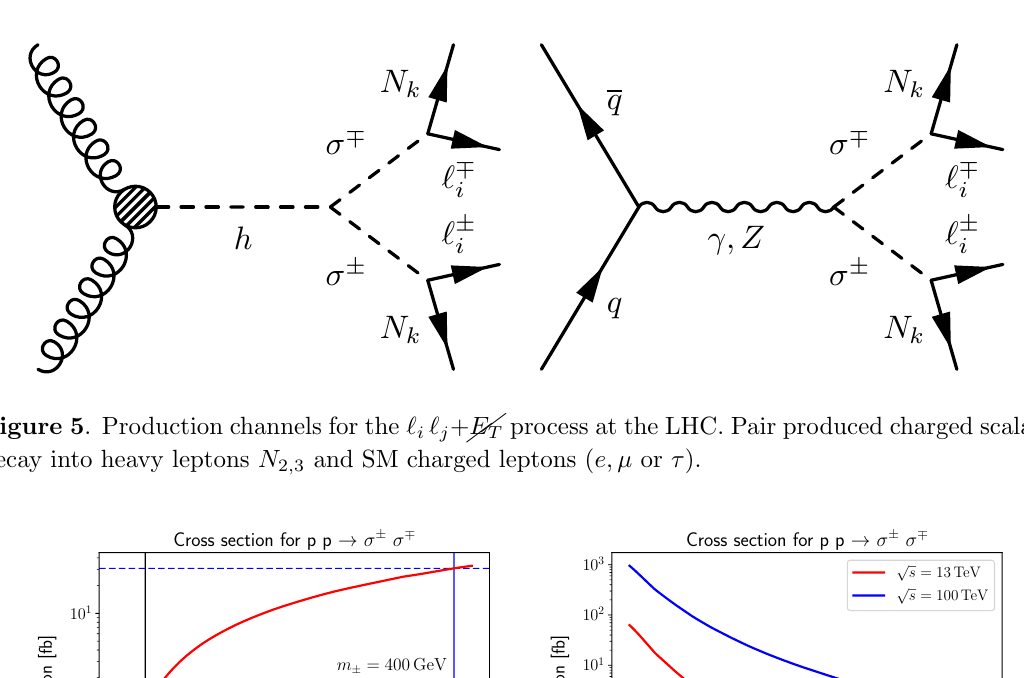
channel. channel. T T